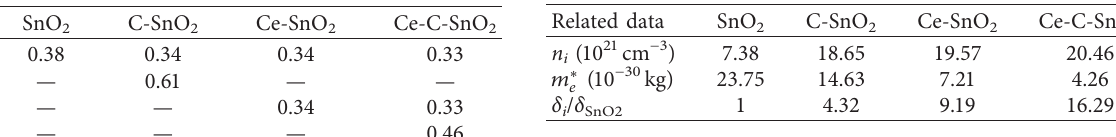
Table 3: Bond populations. Table 4: Related data for